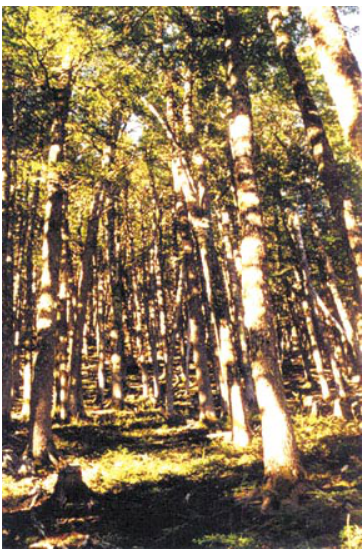
FIGURE 5 . Lenga stand used approximately 30 years ago.